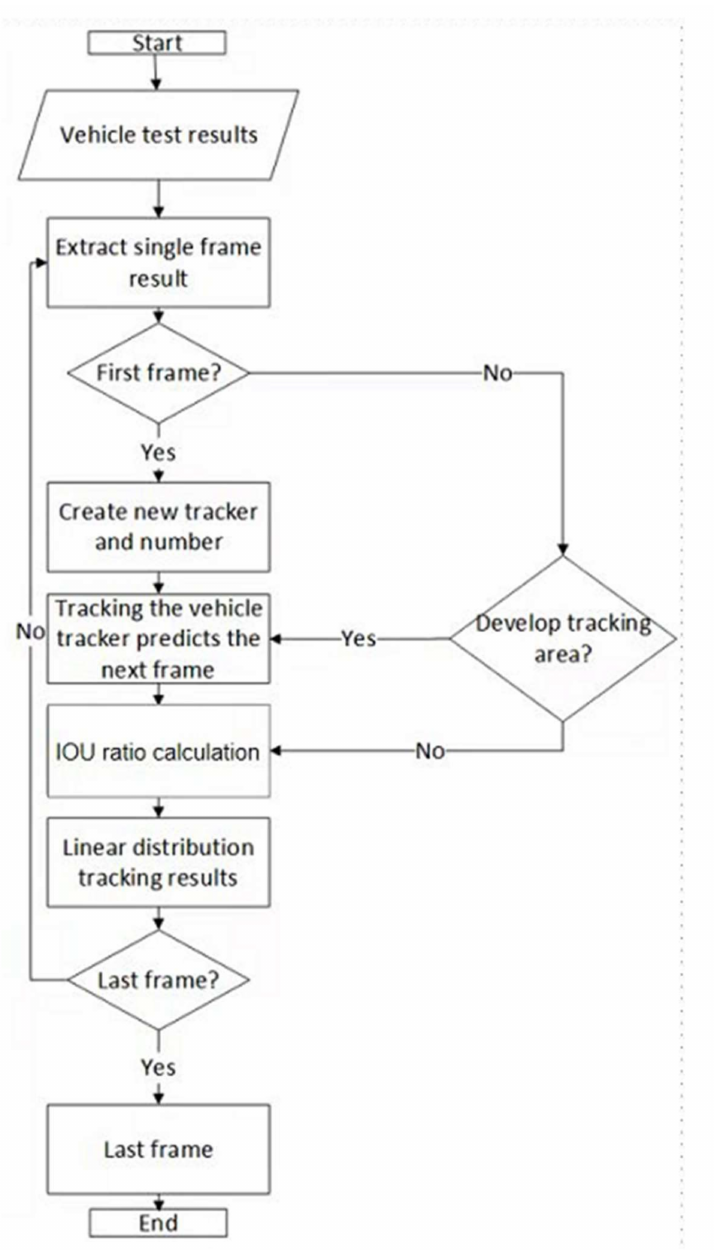
Figure 4. Vehicle trajectory extraction